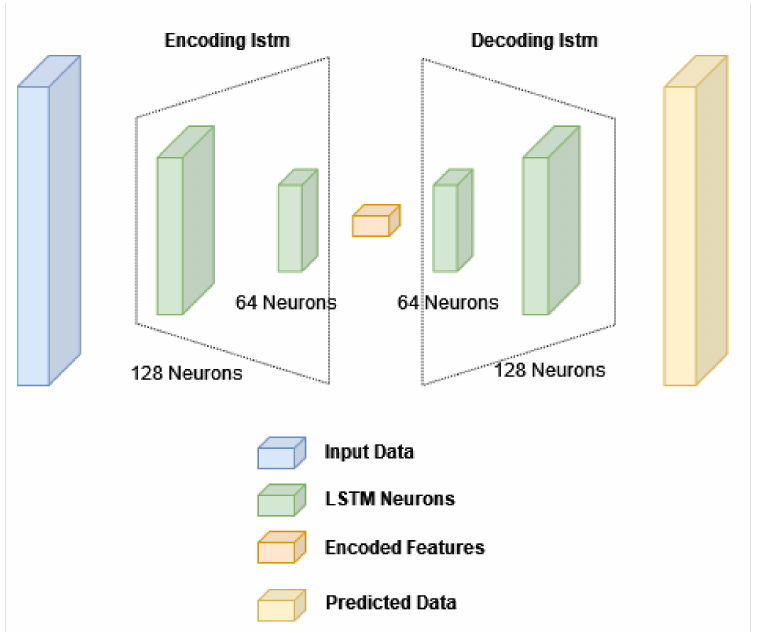
Figure 3. LSTM neural network for SNR enhancement with convolutional (Conv) and LeakyRelu layers. The LSTM layer in time series and sequence data learns protracted correlations among time steps. The layer state comprises the cell state c t and the hidden state (also known as the output state) h t . The output of the LSTM layer for time step t is stored in the hidden state at that time. Information from previous time steps is stored in the cell state. The layer updates the cell state at each time step by adding or removing the information. Finally, gates are used by the layer to control the